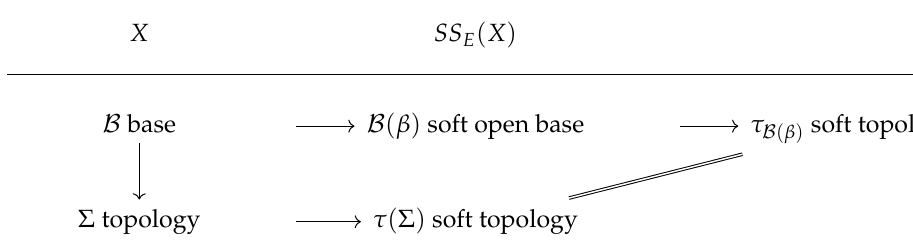
Figure 2. The commutativity diagram involving the two soft topologies in Theorem